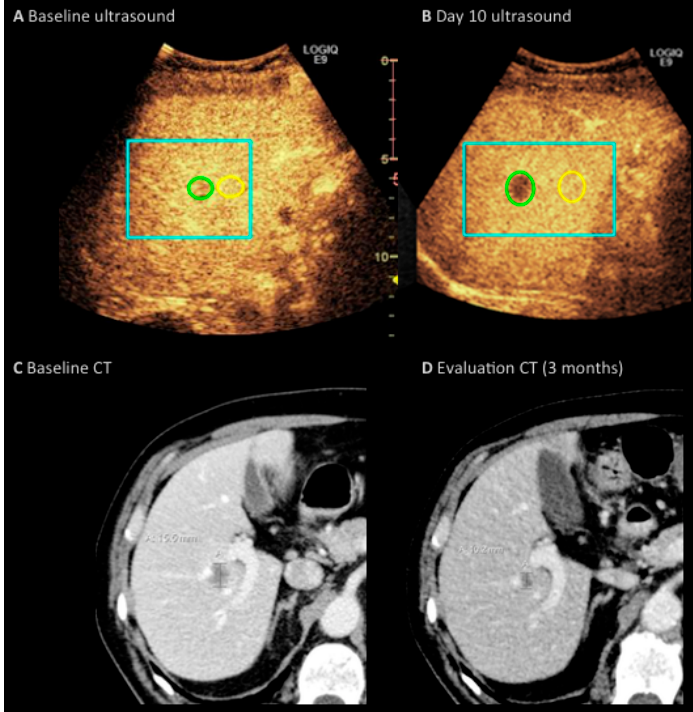
Figure 3. 71-year-old man with metastatic colorectal cancer treated with bevacizumab, capecitabine and oxaliplatin. ( A ) baseline ultrasound scan and ( B ) Day 10 ultrasound scan. The blue frame delineates the motion corrected area; ( C , D ) illustrates Baseline CT and Evaluation CT with a reduction in the size of the metastasis from 16 to 10 mm on longest